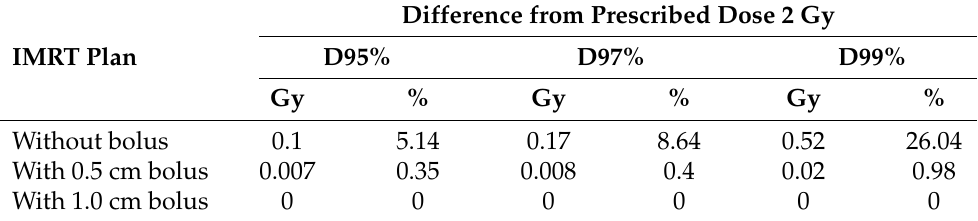
Table 4. Calculated difference between doses calculated by TPS and prescribed dose for the IMRT